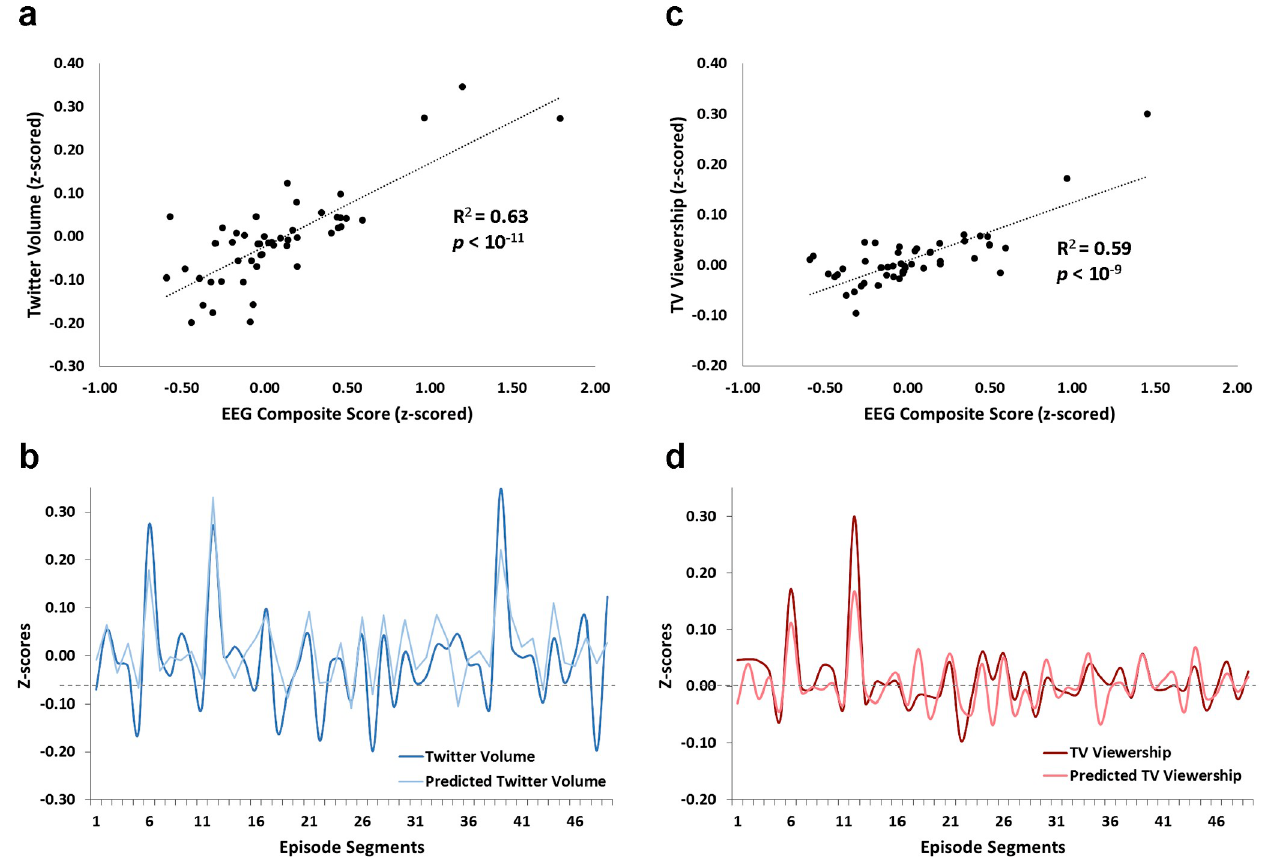
Fig 2. Composite EEG score predicts Twitter volume and TV viewership across program segments. (A) Correlation between minute-by-minute changes in the composite EEG score (consisting of a z-scored average of the fronto-central left-to-right alpha/beta asymmetry, alpha power decrease/theta increase, and theta and gamma power increases) and Twitter volume across discrete program segments (n = 49). (B) Minute-by-minute changes in Twitter volume are plotted against changes in Twitter volume predicted based on the composite EEG score. (C) Correlation between minute-by-minute changes in composite EEG score and TV viewership across discrete program segments (n = 49). (D) Minute-by-minute changes in TV viewership are plotted against changes in Viewership predicted based on the composite EEG score.